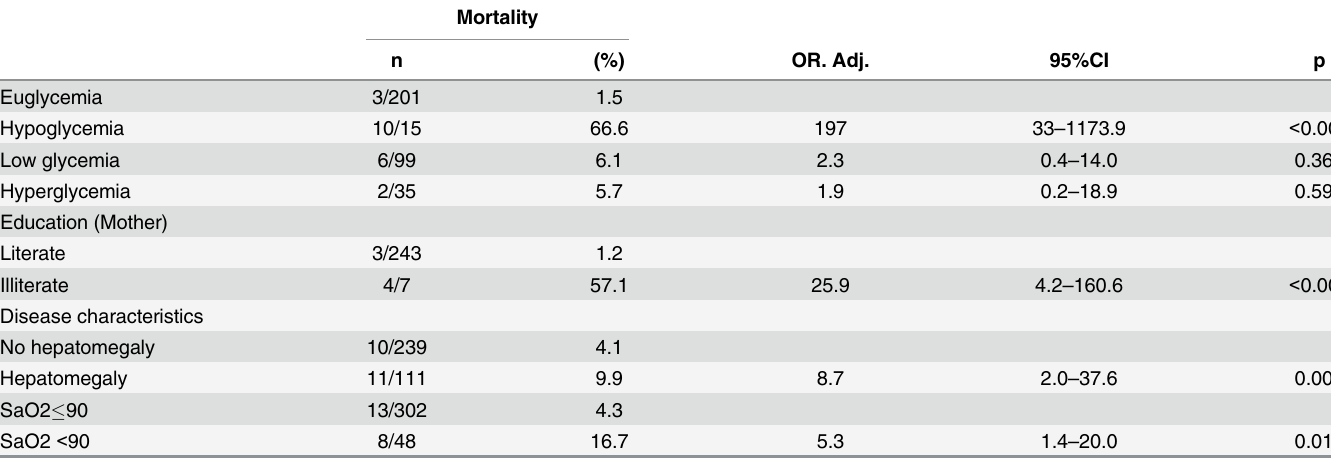
Table 5. Multivariate analysis of the characteristics associated with death for children on admission to Vientiane hospital. Only significative vari- ables are